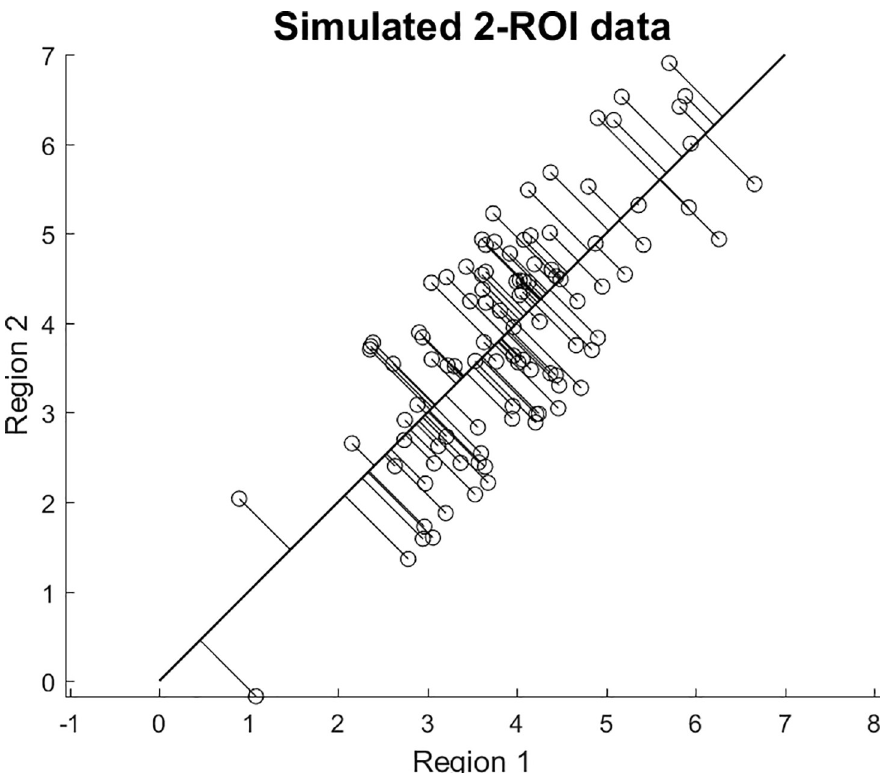
Fig 2. Explanation of residual signal not accounted for by a multivariate thickness pattern. The figure shows a toy example with 2 ROIs (ROI1 = x-coordinate, ROI2 = y-coordinate), and every data point can be represented by a duplet (x,y). Residual activity with regard to the covariance pattern v = [1;1]/sqrt(2) can be understood as the squared shortest distance of every point (x,y) with regard to the straight line y =